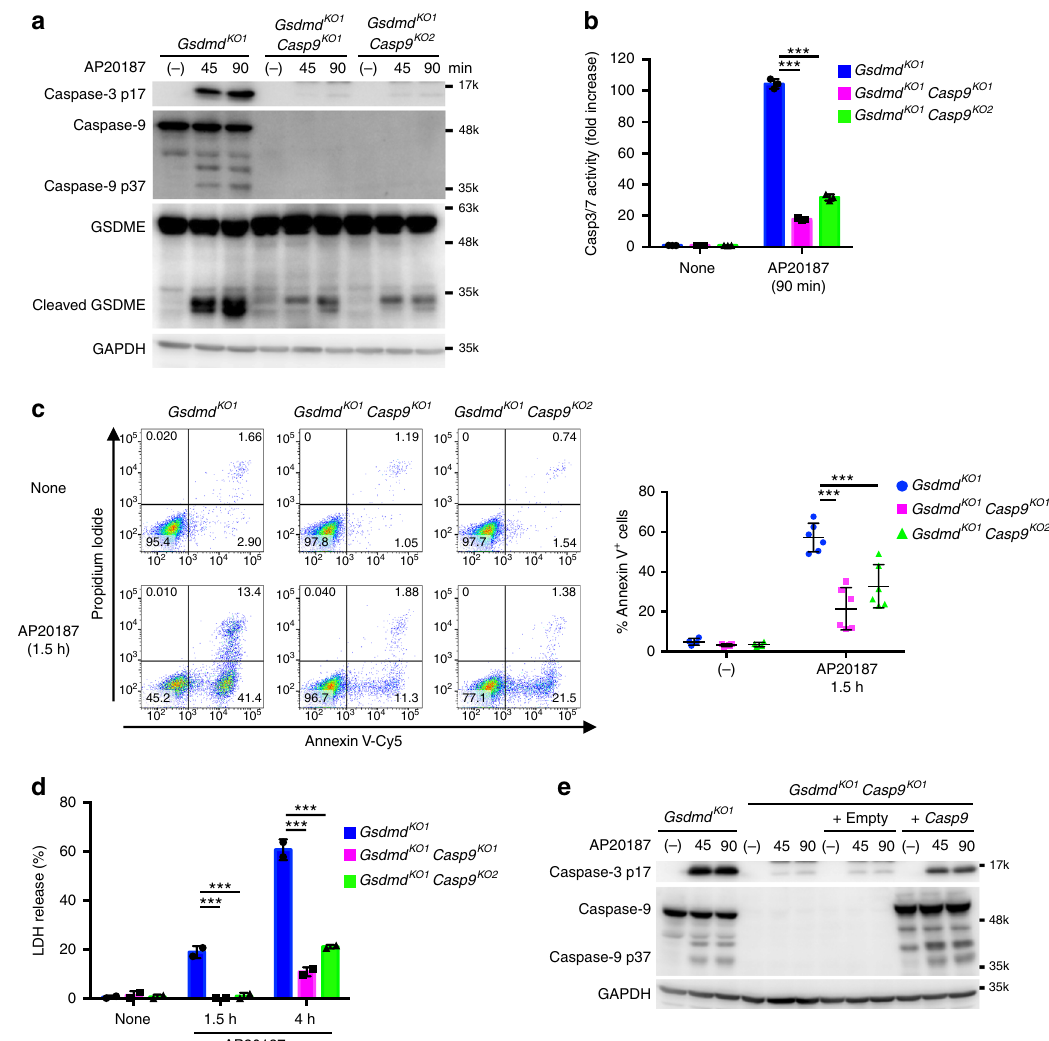
Fig. 5 Caspase-9 is involved in caspase-1-induced apoptosis. a – d Gsdmd -KO and Gsdmd / Casp9 -DKO CL26-iCasp1 cells were treated with 50 nM AP20187 for the indicated times. Western blot detection of cleaved caspases and GSDME in cell lysates ( a ). Caspase-3/7 activity in cell lysates determined using a proluminescent caspase-3/7 substrate ( b ). Flow cytometric analysis of PI uptake and PS exposure ( c ). LDH release ( d ). In b and d , graphs depict the mean ± SD of triplicate ( b ) or duplicate ( d ) cultures, and individual data values are plotted. In c , representative fl ow cytometry pro fi les and the graph that depicts percentages of Annexin V + cells (untreated, n = 4; AP20187-treated, n = 6) from four independent experiments are shown. Horizontal and vertical bars indicate the mean ± SD. Statistical signi fi cance was determined using Bonferroni ’ s multiple comparisons test ( b – d ). *** p < 0.001. e Gsdmd / Casp9 -DKO CL26-iCasp1 cells were transduced or not transduced with Casp9 or empty vector control. The cells were treated with 50 nM AP20187 for the indicated times. Western blot detection of cleaved caspases in cell lysates ( e ). In a , b , d, and e , data are from one representative of three independent experiments with similar results. Source data are provided as a Source Data fi le. (See also Supplementary Fig.